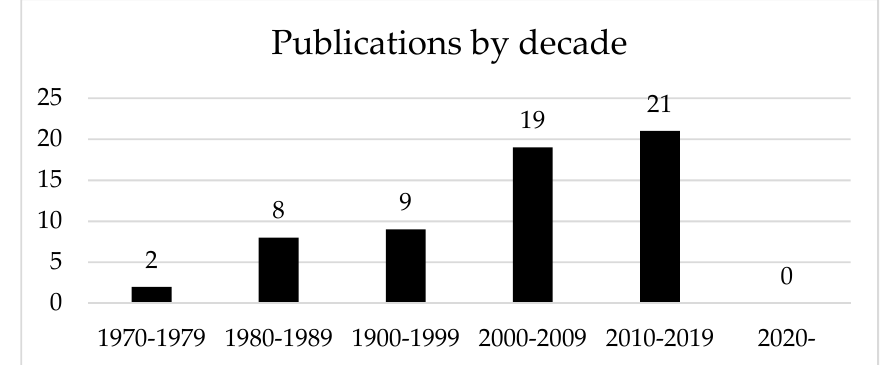
Figure 1. Publications by decade. Table 2. Top 5 most productive countries .